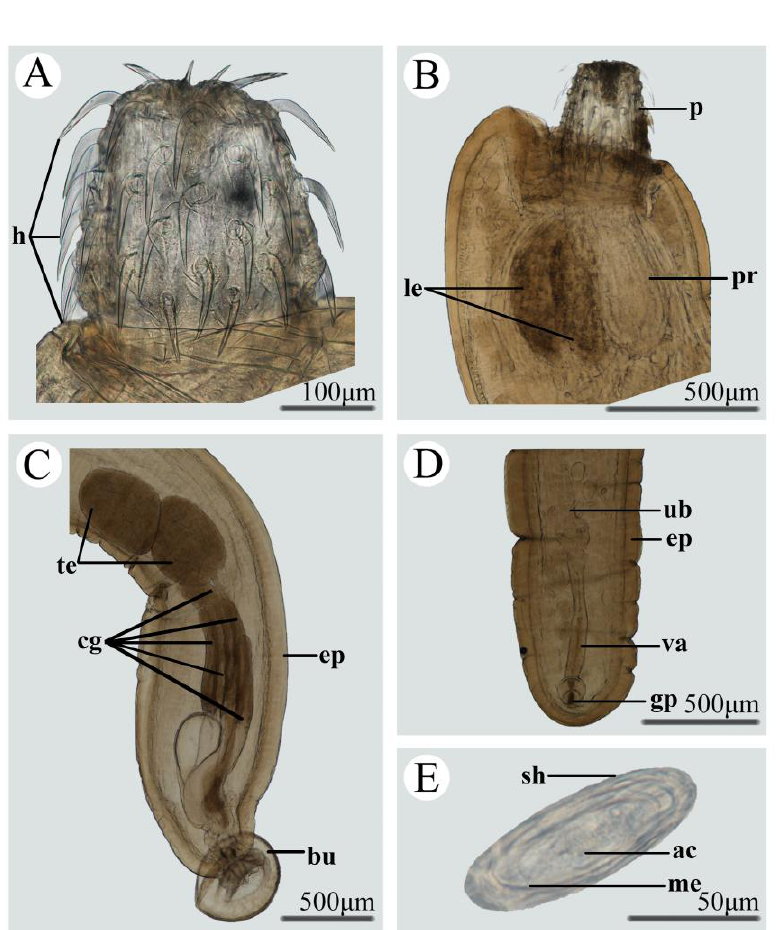
Figure 1. Photomicrographs of Pseudoacanthocephalus bufonis . ( A ) Proboscis; ( B ) Presoma of female; ( C ) Metasoma of male; ( D ) Metasoma of female; ( E ) egg. Abbreviations: ac, acanthor; bu, copulatory bursa; cg, cement glands; ep, epidermis; h, hooks; le, lemniscs; me, membrane; p, proboscis; pr, proboscis receptacle; sh, shell of egg, te, testis; ub, uterine bell; va,